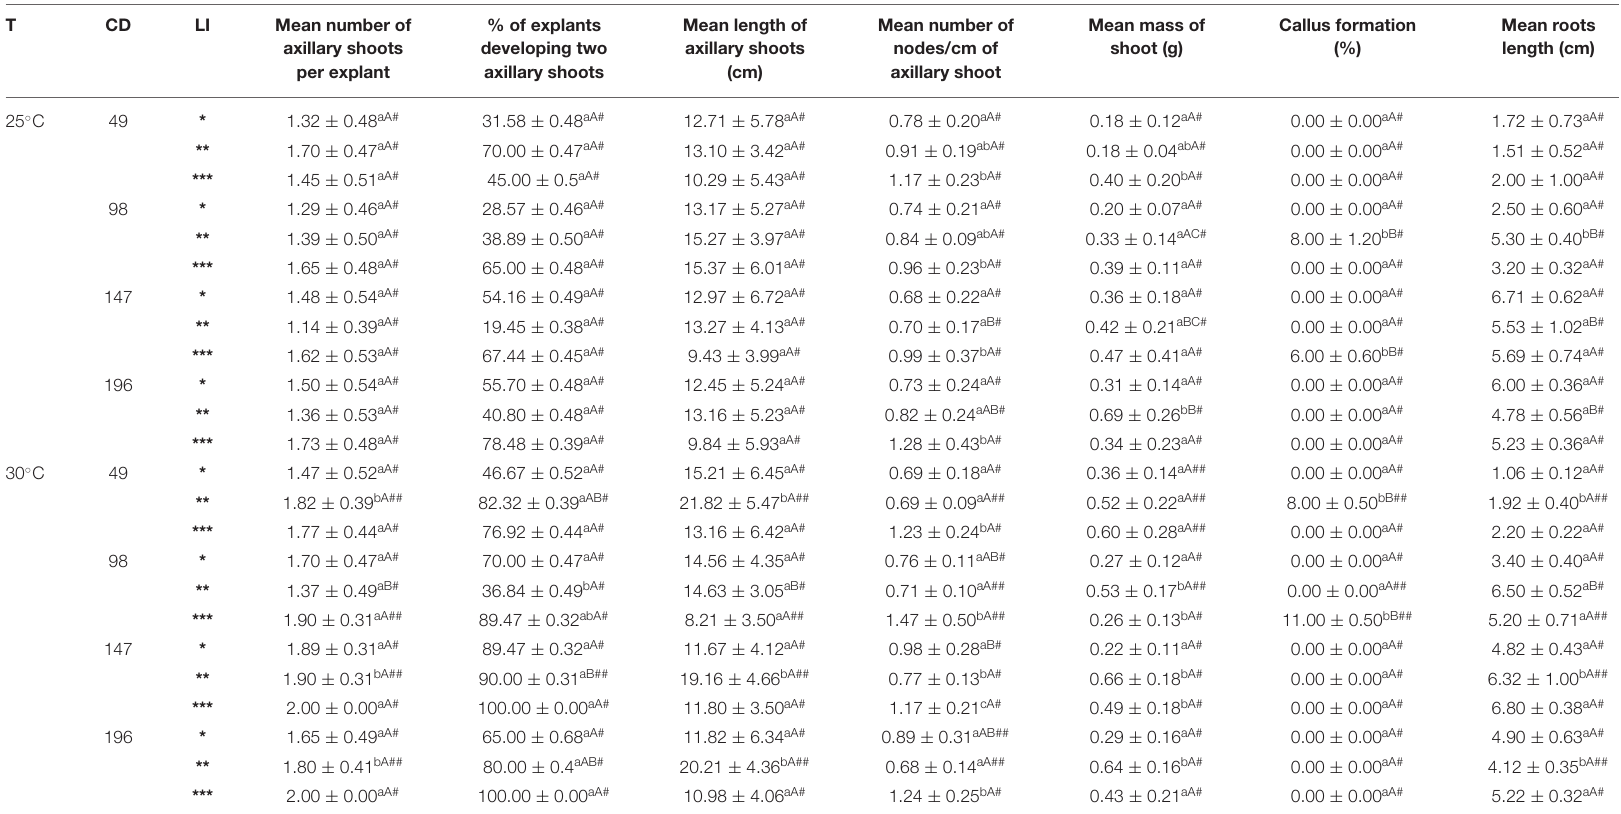
Different letters indicate significant differences (p < 0.05) according to the Kruskal–Wallis test; small letters—differences between samples from three LI; capital letters—differences between samples from four culture durations measured in days, #,##—differences between samples derived from two temperature regimes within a single culture duration